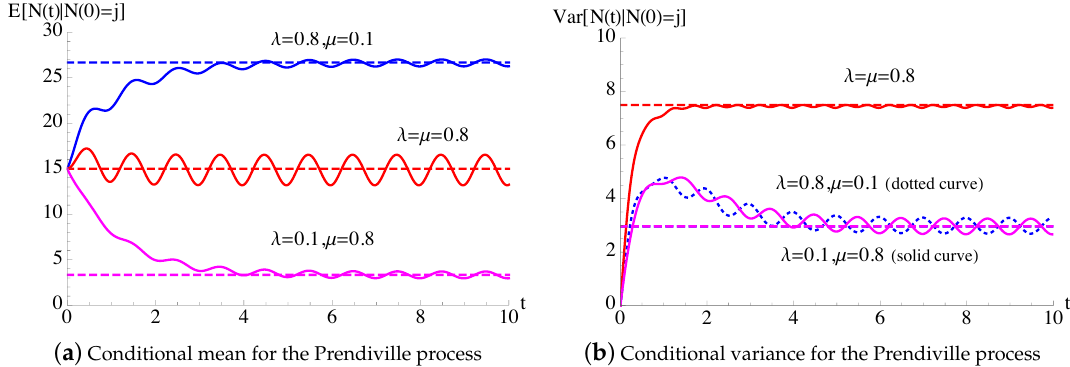
Figure 14. For the Prendiville process of Figure 13, the conditional mean and the conditional variance (69) are plotted as function of t for j = 15, K = 30, a = 0.9, Q = 1.0 and for some choices of λ and µ